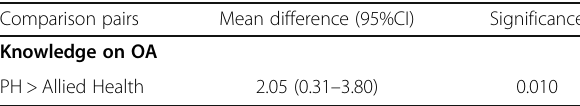
Table 3 Repeated measures